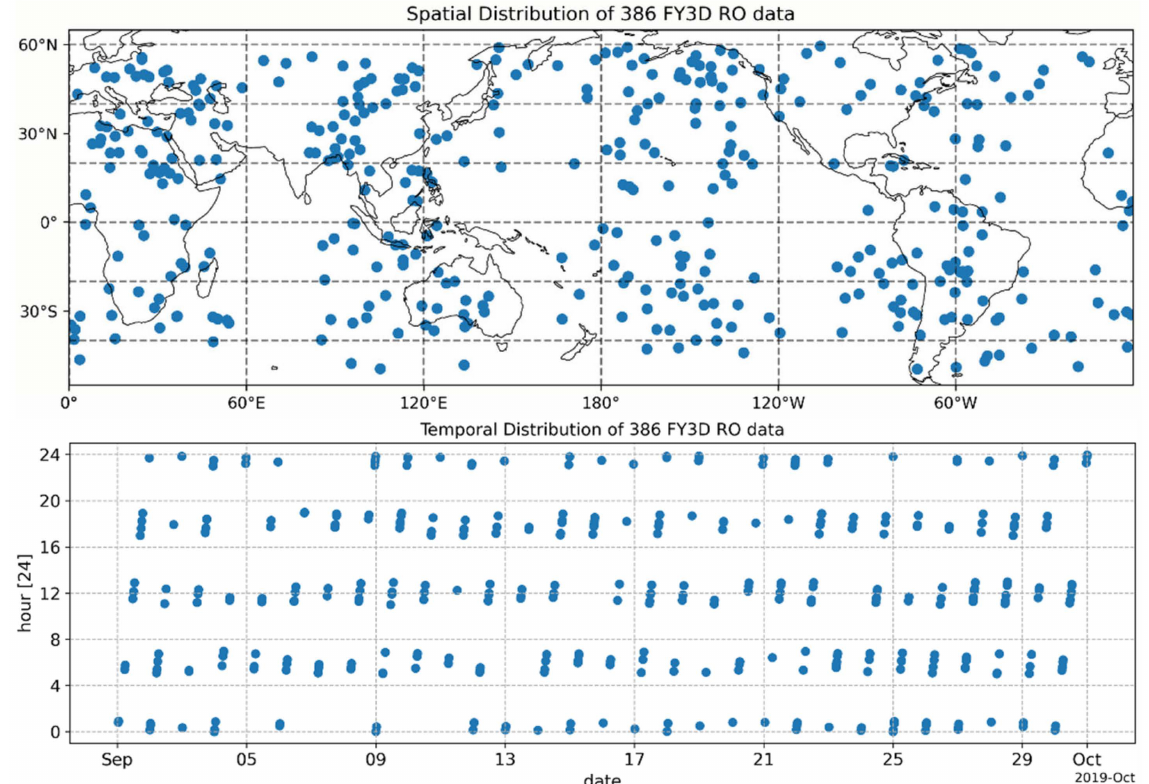
Figure A7. Spatial ( upper ) and temporal ( lower ) distribution of 386 samples after collocation and 4QC. In general, these samples are evenly distributed in longitude and latitude, and are evenly distributed in different hours on each day in